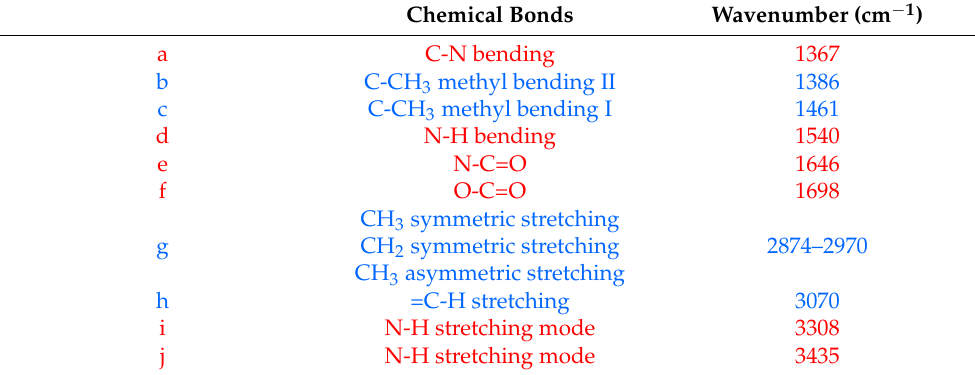
Table 1. Chemical bonds assignment corresponding to